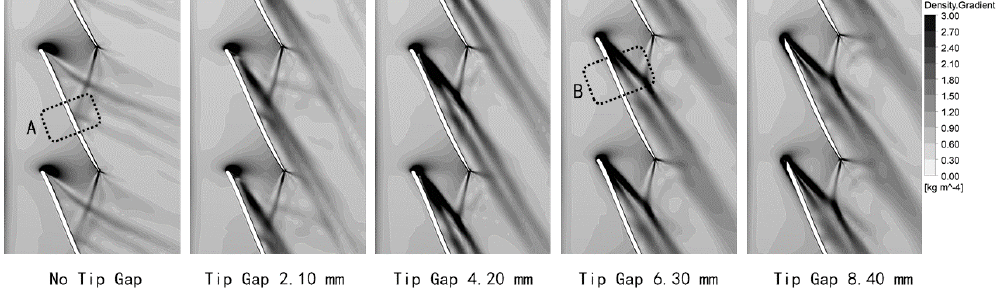
Figure 12. Schlieren figure on 98% of the span surface. The flow direction is from the left to the right.